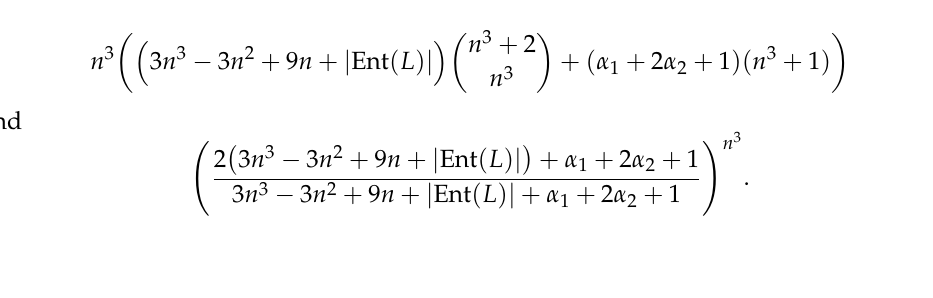
Table 3. Study of the generators of the ideal I PT ( L )